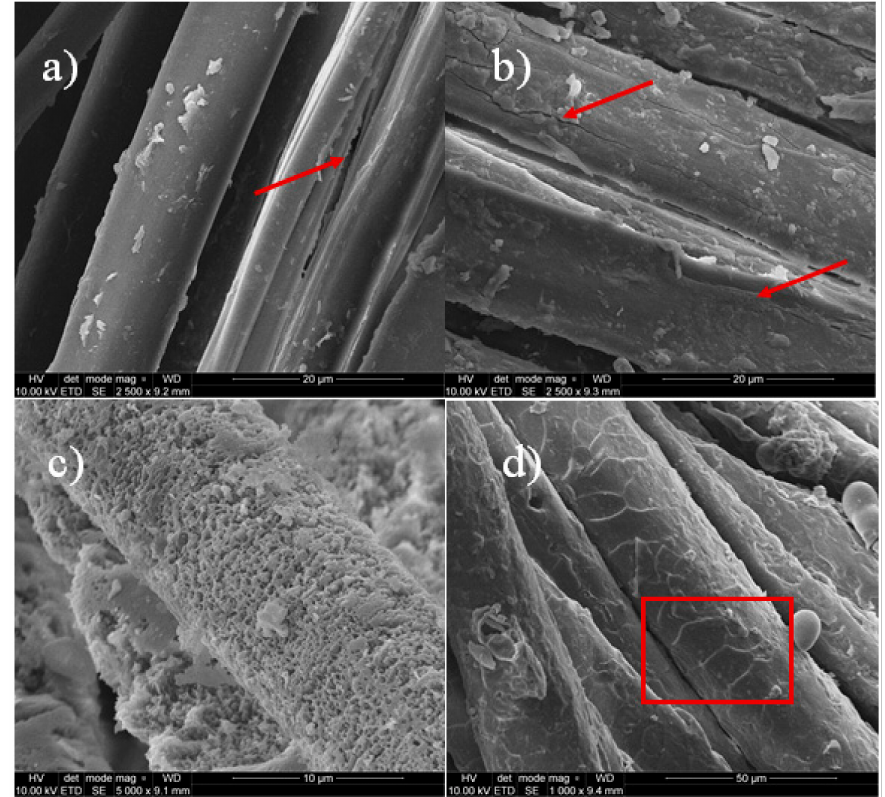
Figure 2. SEM micrographs of threads: ( a ) silk C5/b11, ( b ) silk C5/b9-2, ( c ) silk C5/b5-1, and ( d ) wool C6/b2 (magnitude 2500 × ). Arrows indicate visible fractures of the silk fibres, rectangle highlights scales characteristic for woollen